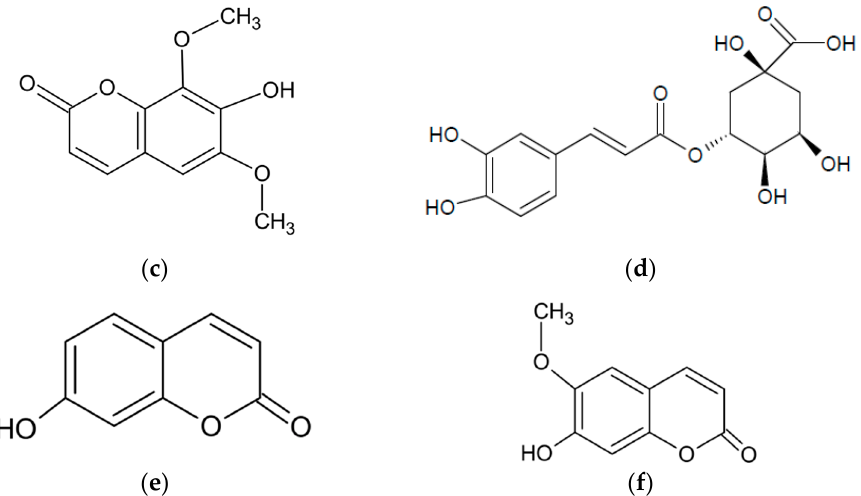
Figure 2. Chemical structure of the most frequent compounds isolated from A. abrotanum : artemisetin ( a ); quercetin ( b ); isofraxidine ( c ); chlorogenic acid ( d ); umbelliferone ( e ), scopoletin ( f ). Table 2. Chemical composition of A. abrotanum